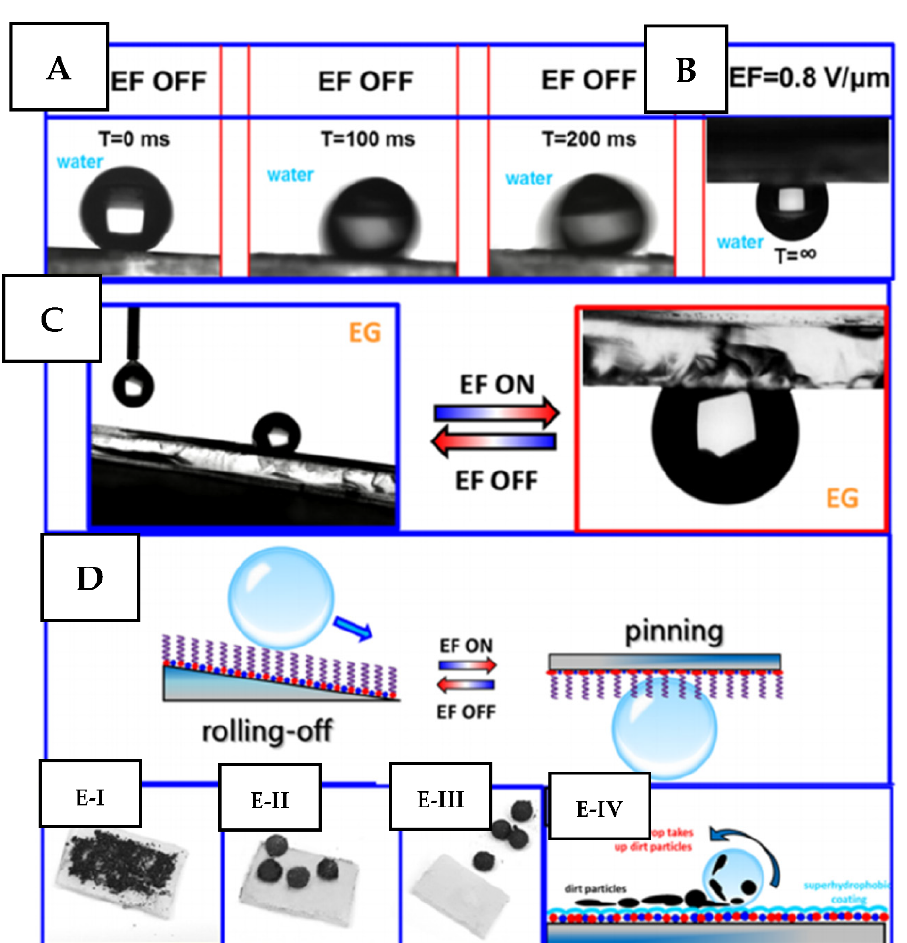
Figure 13. Superoleophobicity and reversible water and ethylene glycol adhesion switching on − C 6 H4 − C 8 F 17 grafted polyvinylidene fluoride/poly(methyl methacrylate) (PVDF/PMMA) fibers: ( A ) a time-resolved image of a 5-µL water droplet at a roll-off angle of 4° without the electric field, ( B ) a resolved image of a 5-µL water droplet at 180° with an EF application; ( C ) optical images of re- versible EG adhesion under EF switching on/off; ( D ) a schematic illustration of EF-induced liquid